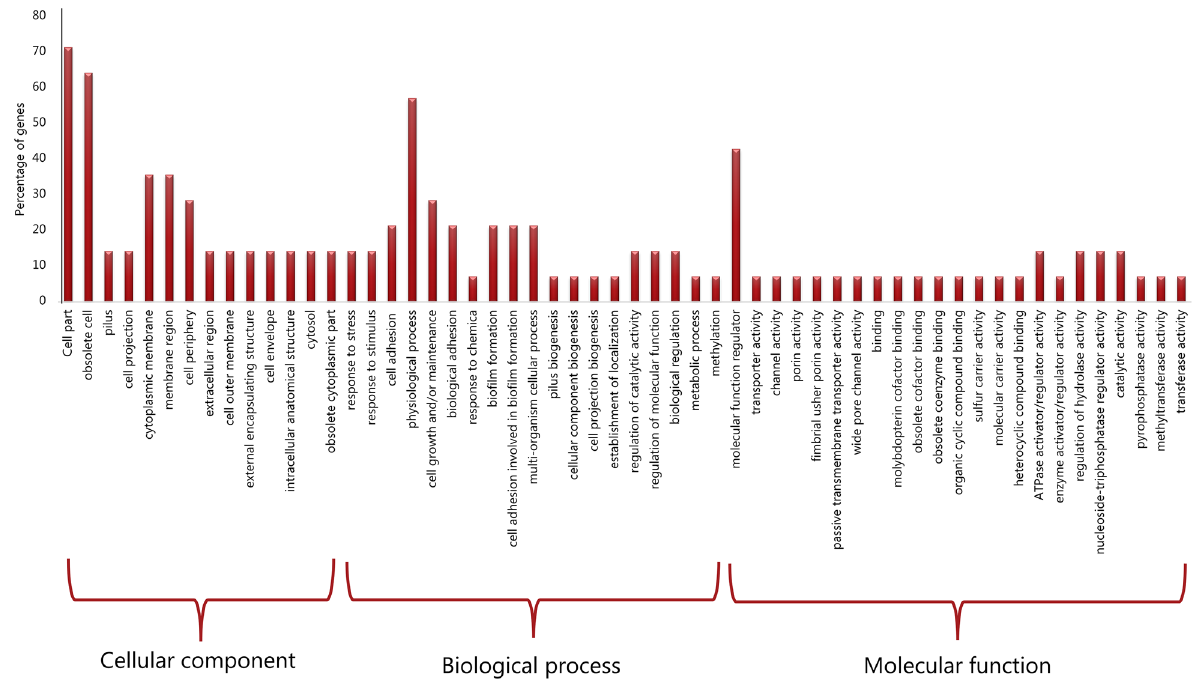
Figure 4. Gene oncology enrichment depicted from Part C representing unique CDS for S. enterica subsp. salamae serovar 42:r-.